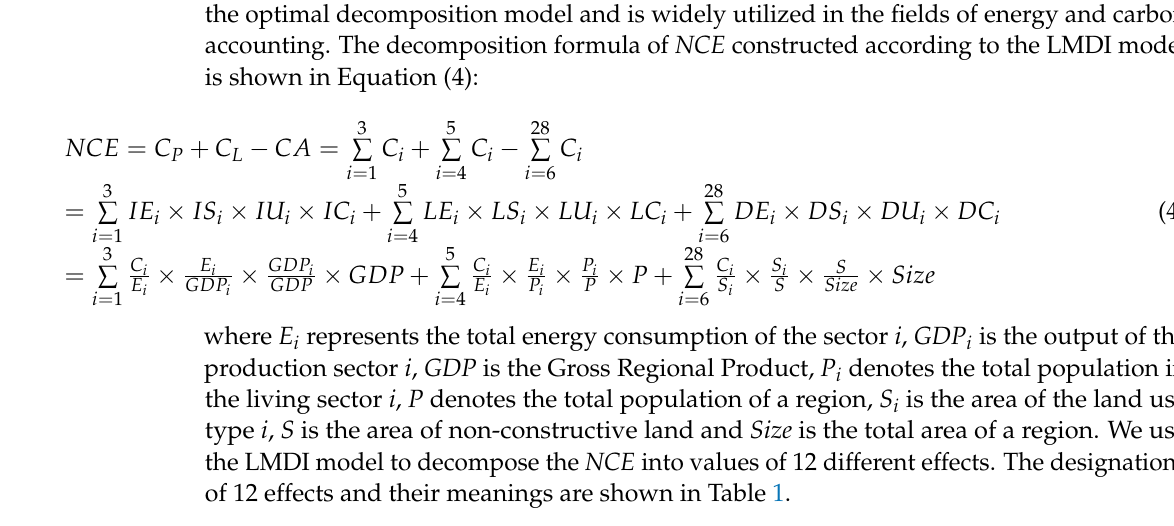
Table 1. The designations of 12